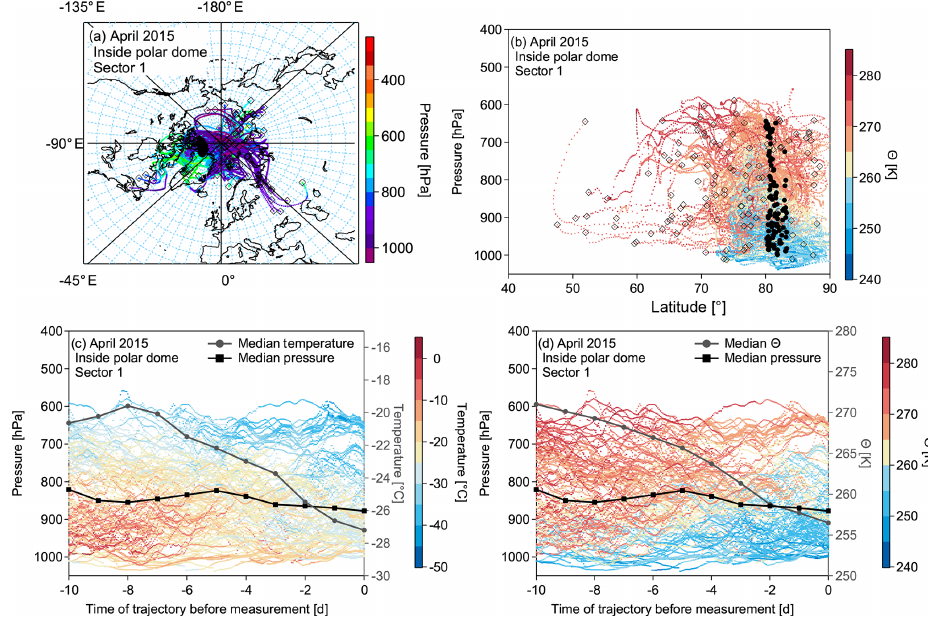
Figure 12. (a) Trajectories of the most dominant sector 1 for air masses inside the polar dome. The color code represents the pressure along the trajectories. (b) The same trajectories as in (a) as a function of pressure and latitude, color coded by potential temperature. In both (a) and (b) black circles denote the initialization point of the trajectory along the flight track. The black open squares show the position of the trajectory 10d back in time. Panels (c) and (d) show height–time cross sections with pressure representing the altitude of the trajectories (left axis) for the trajectory evolution over the 10d of travel, with the color code denoting the temperature (c) and potential temperature (d) . The black line marks the median pressure of the trajectory cluster at the individual time steps, and the grey line indicates the median temperature and median potential temperature, respectively. Note that only every 20th trajectory is plotted for figure